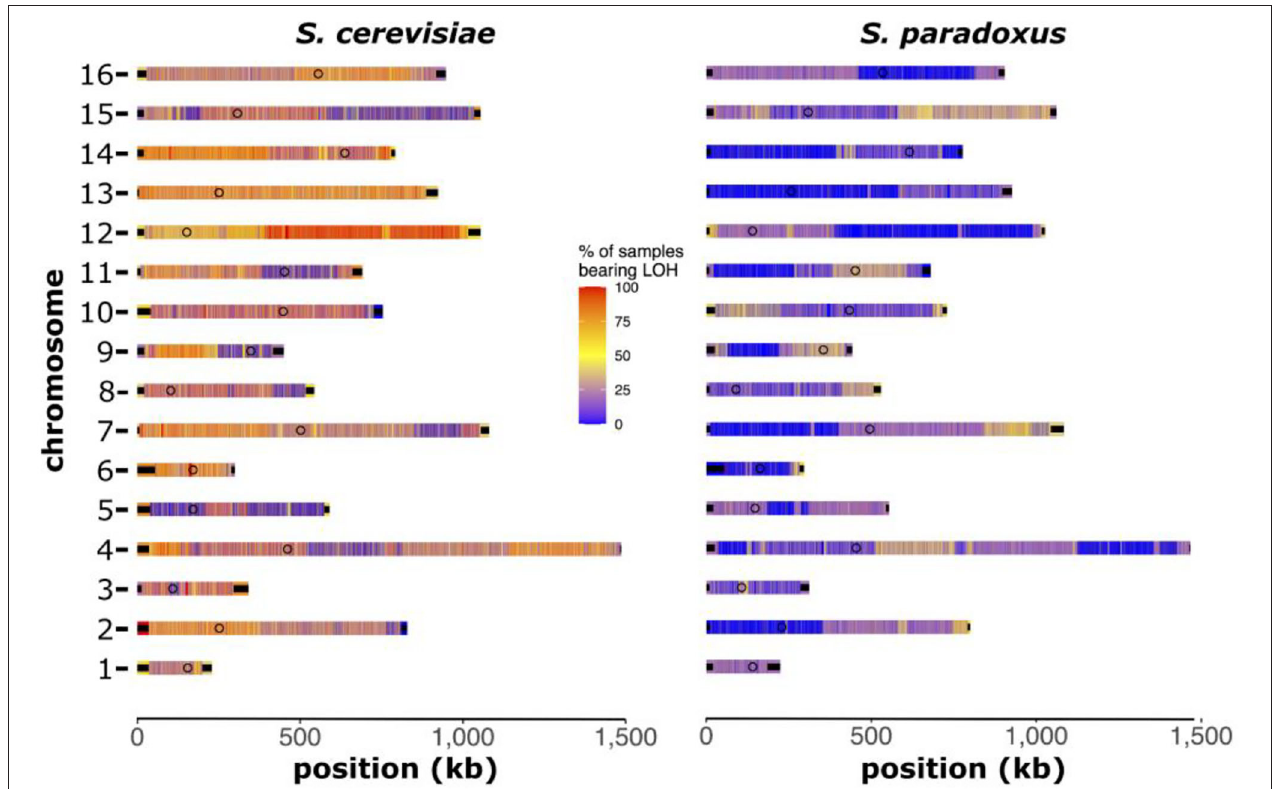
FIGURE 8 | Chromosomal maps of loss of heterozygosity (LOH). Heatmaps of each chromosome depicting the regions with high (red) or low (blue) levels of LOH. Regions of high LOH are homozygous for markers from that parental reference genome. Heatmap color indicates the percentage of samples bearing LOH at that region. This analysis was performed on S. cerevisiae × S. paradoxus hybrids with at least 20% of the hybrid genome inherited from each species ( n =